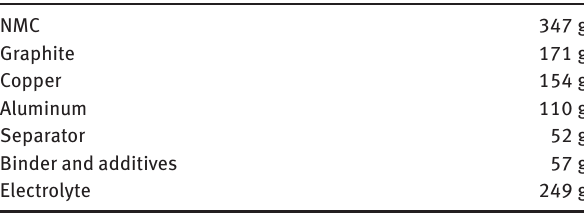
Laminate material for pouch assembly is not taken into account.